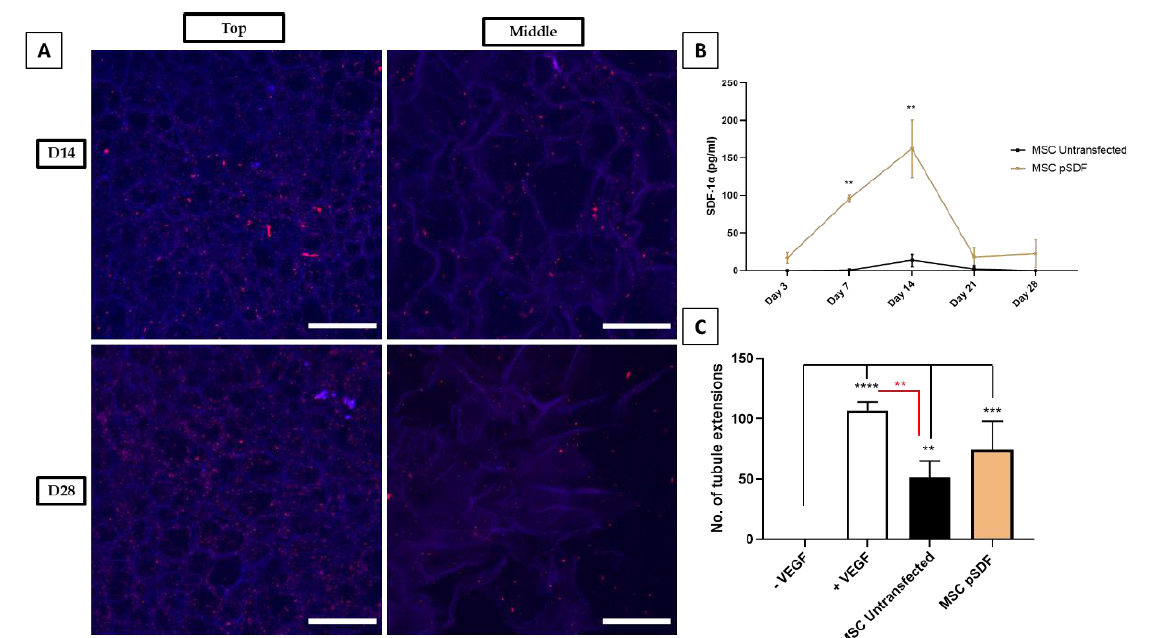
Figure 6. ( A ) Cy3-tagged GET* N/P 8-pDNA nanoparticles on coll–nHA (100% wt.) scaffolds were imaged using confocal microscopy both on the top, and in the middle of coll–nHA scaffolds, shown in blue, at day 14 and day 28 post-seeding. Scale bar = 100 µm. ( B ) SDF- 1α (pg/mL) expression was significantly higher in transfected cells at day 7 and day 14 compared to untransfected control cells ( p < 0.01 **). ( C ) Conditioned medium from pSDF- 1α -transfected cells elicited formation of significantly more tubules than negative controls ( p < 0.001 ***). The positive controls were significantly different to untransfected MSCs, but not pSDF- 1α -transfected cells, shown in red ( p < 0.01 **). ( p < 0.0001 ****). Error bars represent ±SD, n = 3 tested in triplicate.